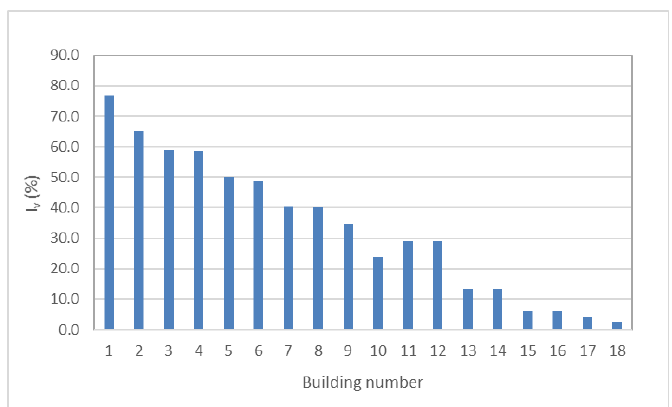
Figure 12. Distribution of I v for 18 buildings analyzed by pushover analysis.